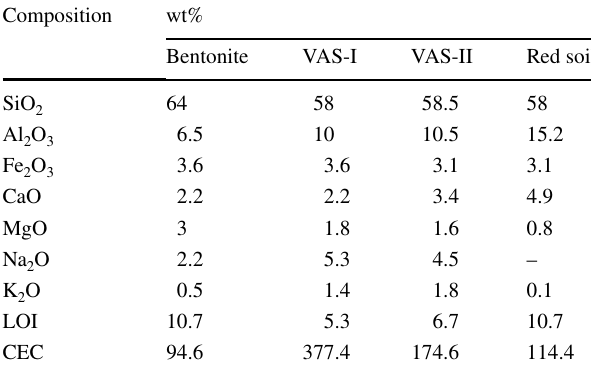
Table 2 Chemical analysis and cation exchange capacity of dried clay minerals adsorbents